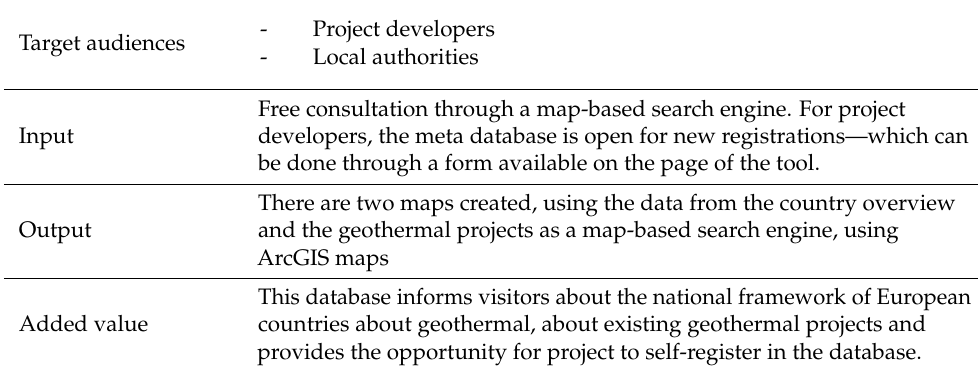
Table 9. Database of geothermal projects.